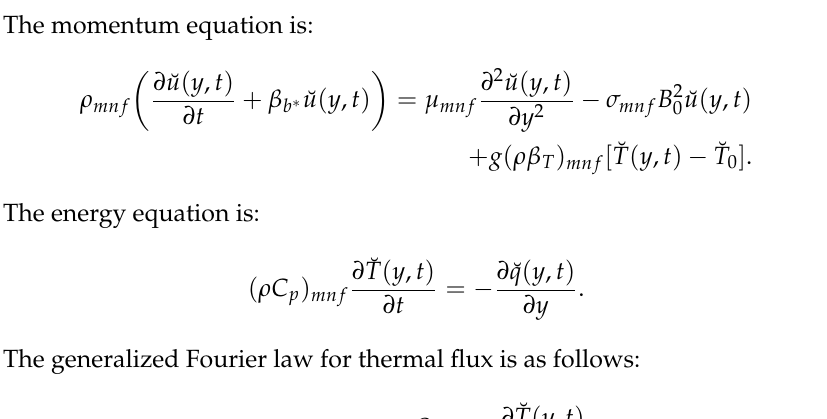
Figure 1. Physical